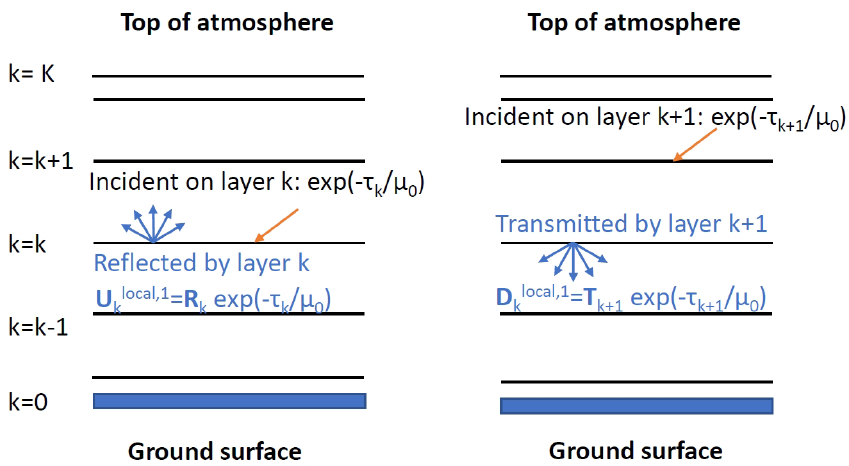
(cid:16) (cid:17) (cid:16) (cid:17) U local , 1 D local , 1 and downward first-order k k